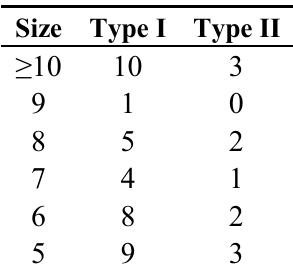
Table 4. Number of species-specific groups of a certain size in our dataset for Type I and Type II